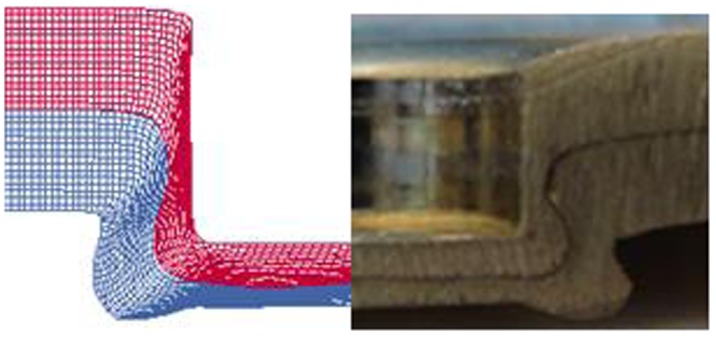
Cross-section comparison [62].